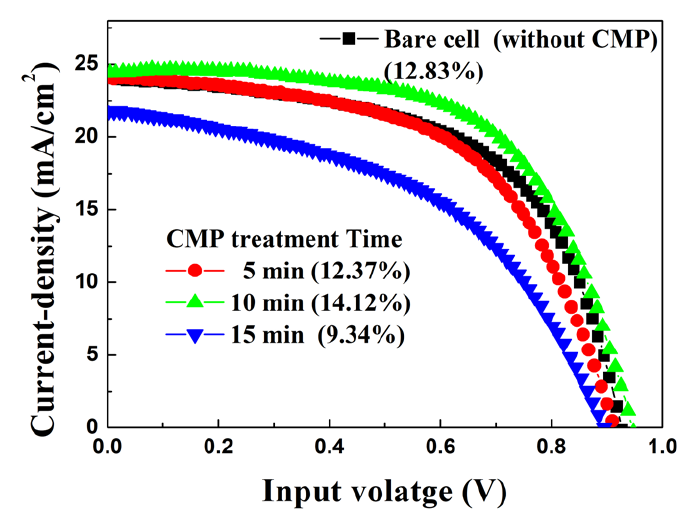
Figure 9. Current density of perovskite solar cells as a function of CMP treatment time.